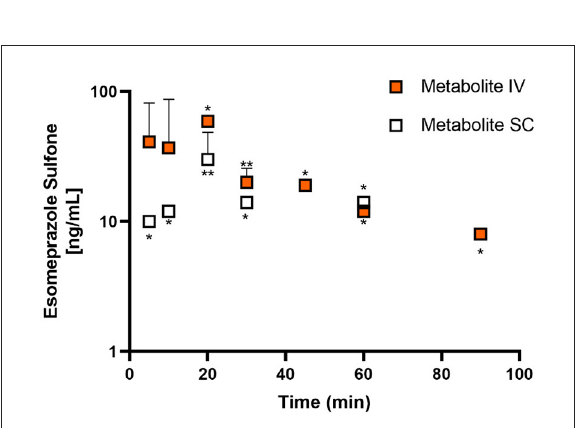
FIGURE2 Mean plasma esomeprazole sulfone concentration (logarithmic scale) vs. time (hr) profiles for adult goats ( n = 5) following intravenous (IV) single dose administration of 1.0 mg/kg of esomeprazole (orange) or subcutaneous (SC) single dose administration of 2.0 mg/kg of esomeprazole (white). Mean is represented by a circle with upward standard error bars. * indicates n for the time point if < 5 animals (*: n = 1; **: n =